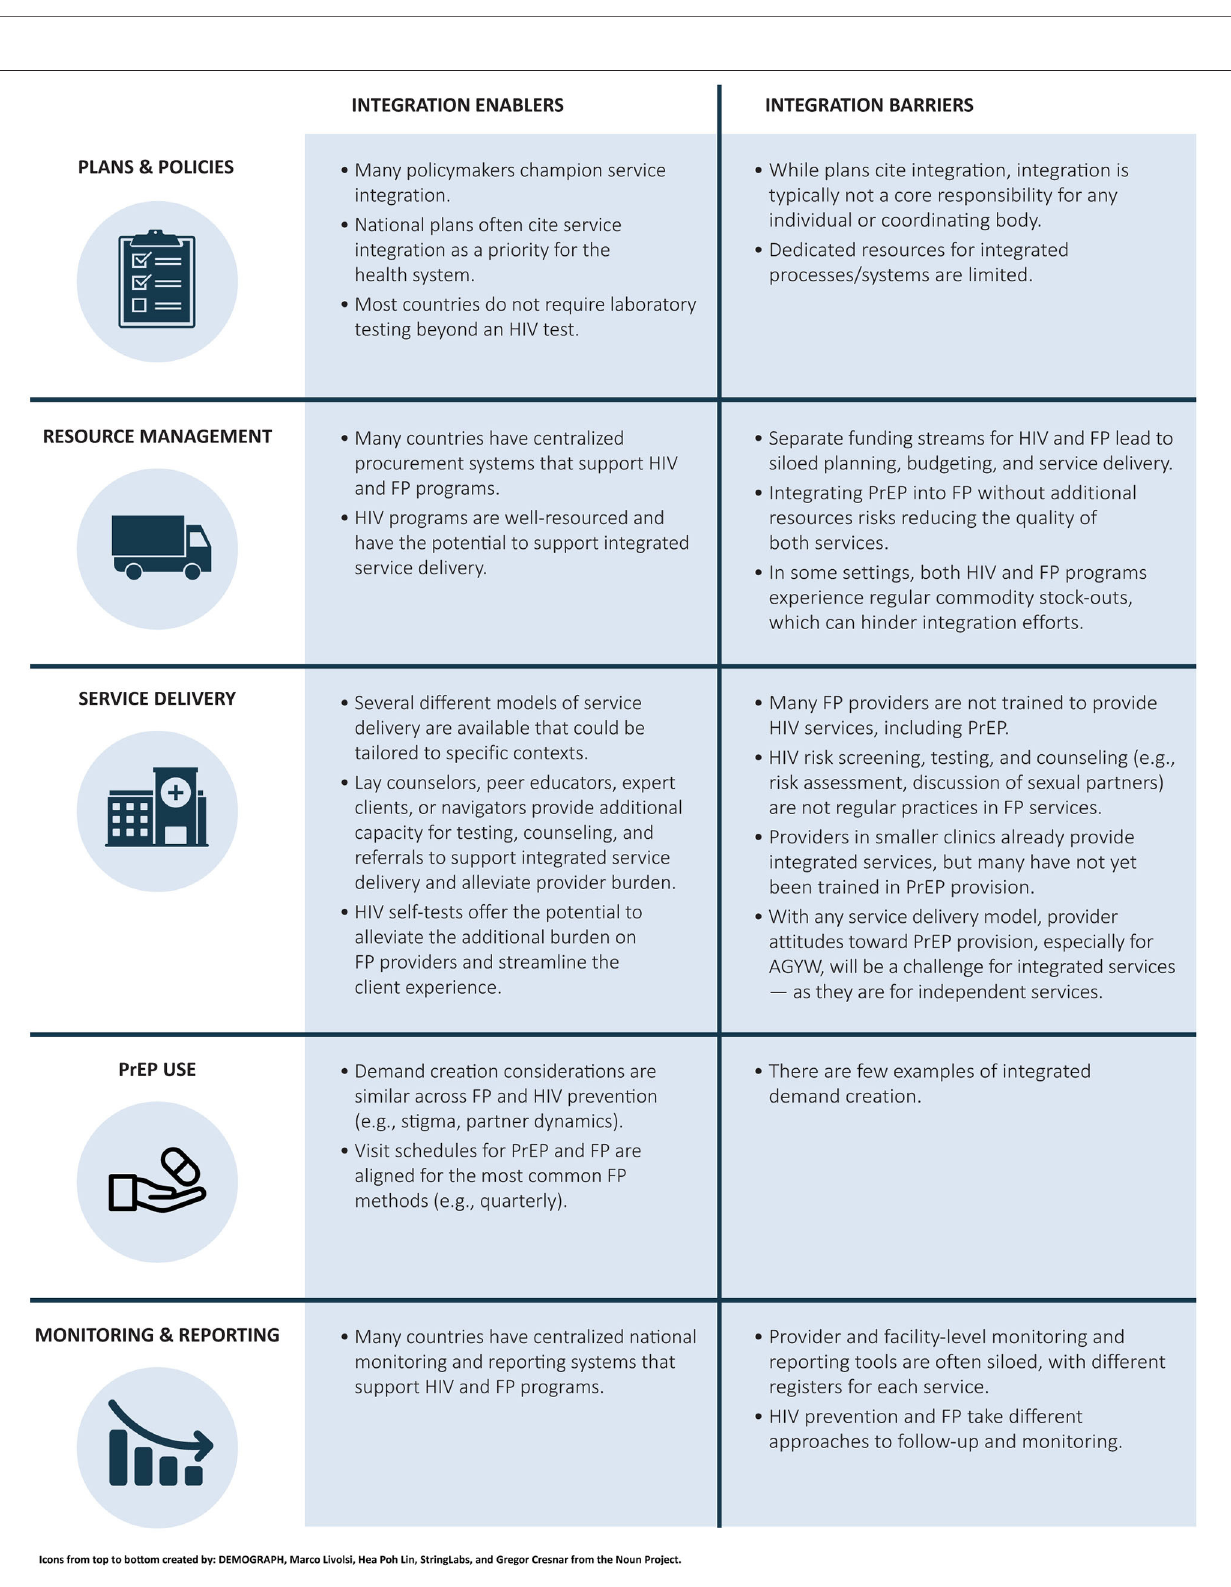
Frontiers in Reproductive Health |